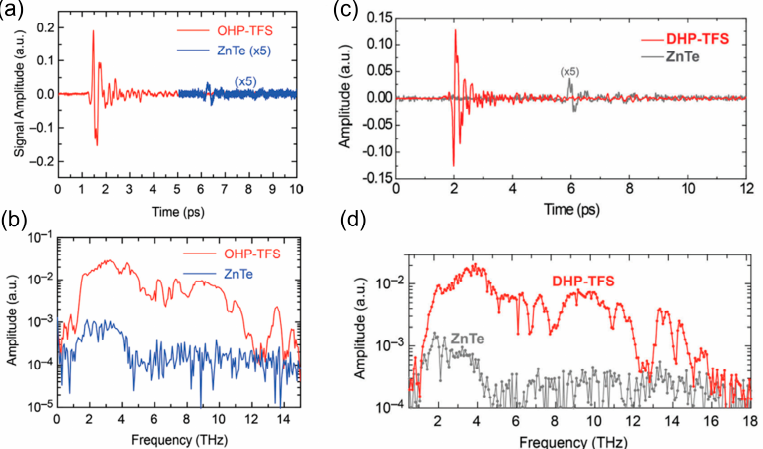
Figure 21. ( a ) Time and ( b ) frequency-domain amplitudes of the THz waves generated in a 0.31 mm thick OHP-TFS [28]; ( c ) time and ( d ) frequency-domain amplitudes of the THz waves generated in a 0.15 mm-thick DHP-TFS at a 1560 nm wavelength [33].